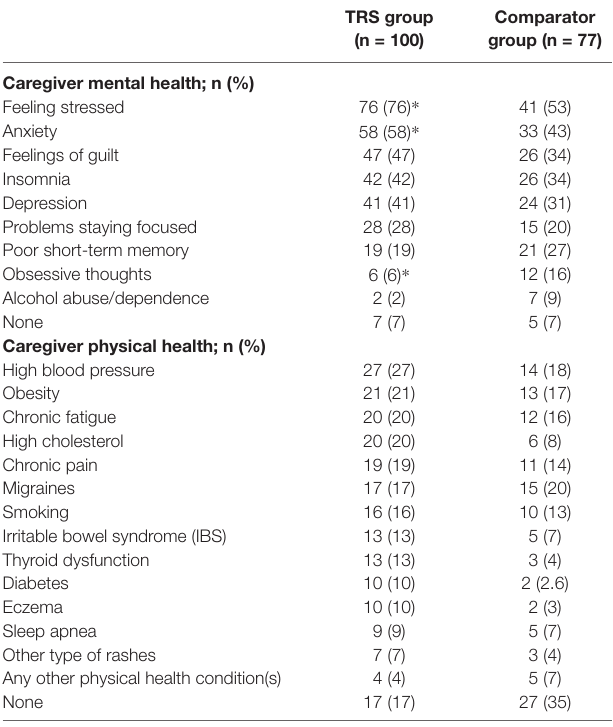
TABLE 3 | Impact on caregiver mental and physical health (incidence